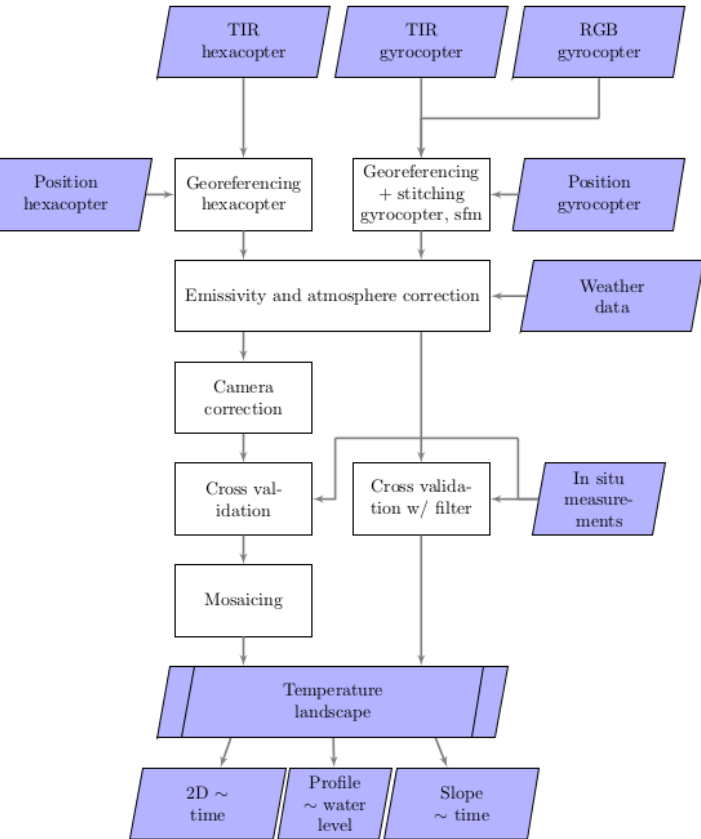
Figure 6. Correction and processing